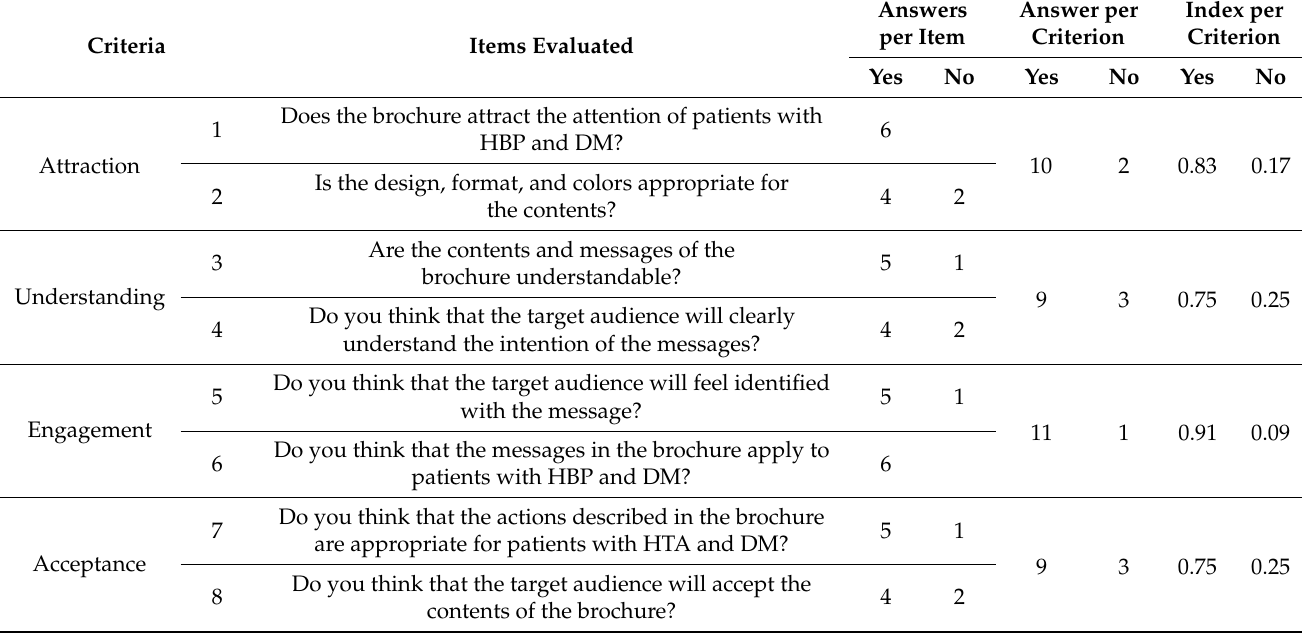
Table 2. Technical validity by expert